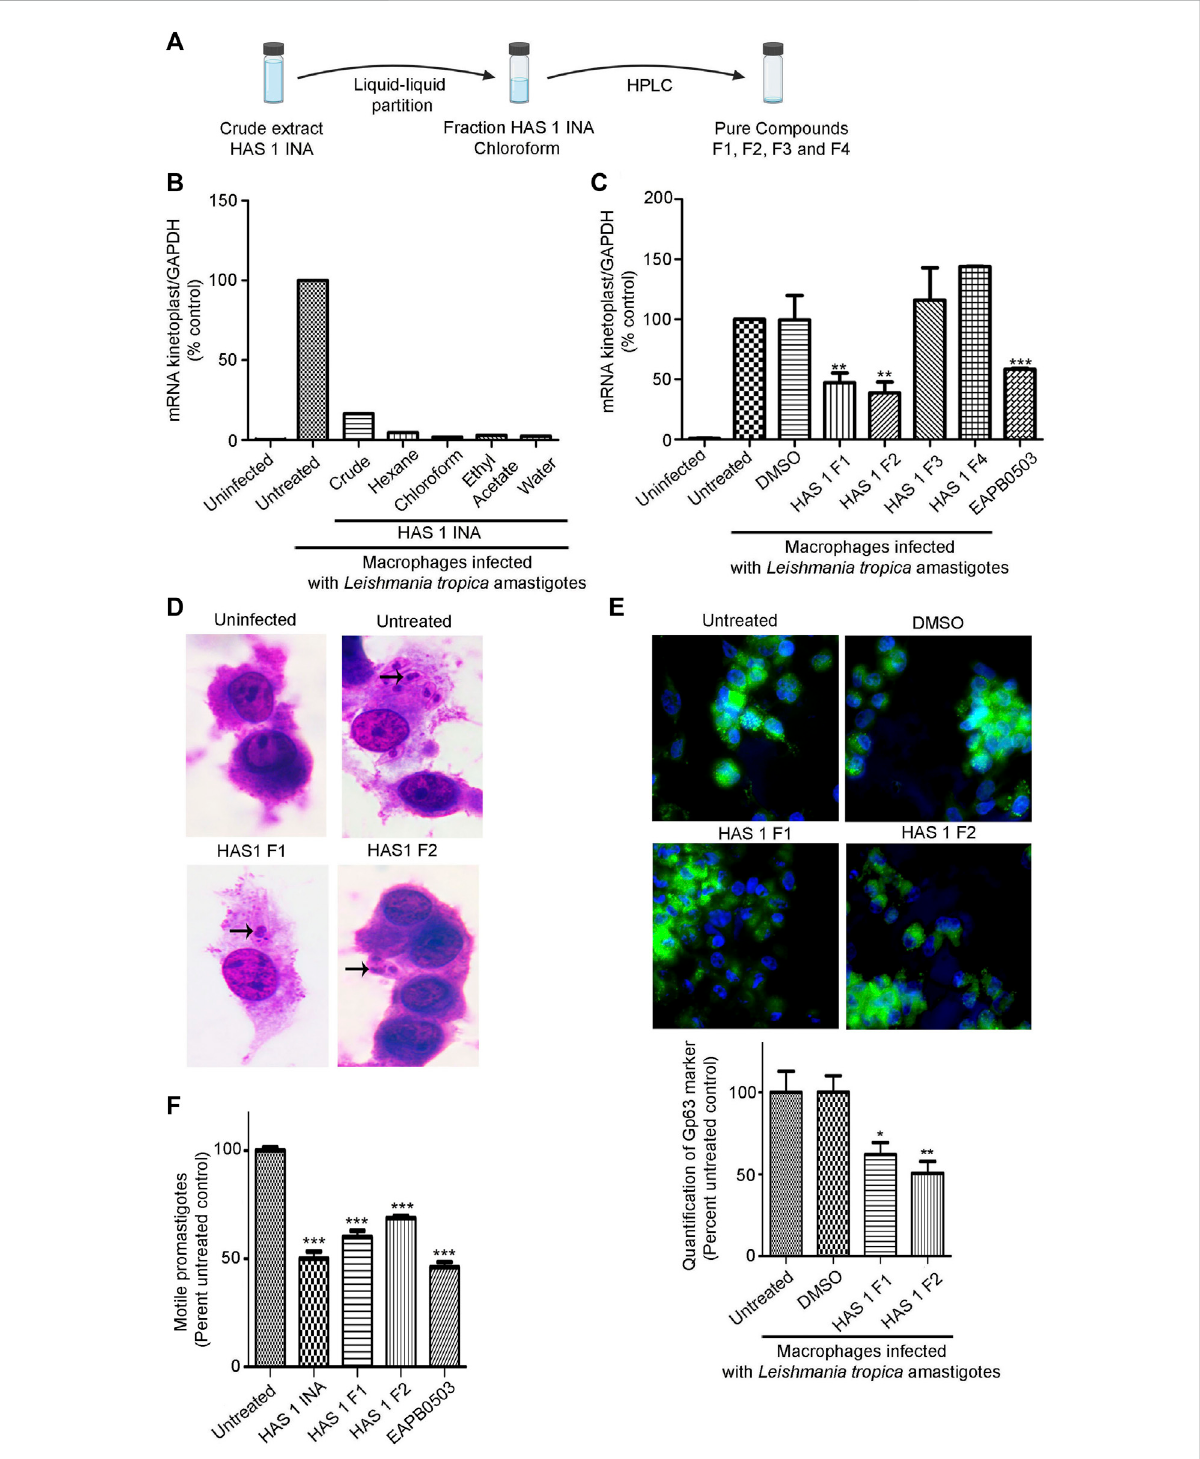
FIGURE 3 Bio-guided fractionation of the antileishmanial compounds of HAS1 INA. (A) . An upscaled fermentation of the HAS1 INA crude was fi rst subjected to liquid-liquid partition generating four fractions: HAS1 INA Hexane, HAS1 INA chloroform, HAS1 INA Ethyl Acetate, and HAS1 INA Water. HAS1 INA chloroform was further fractionated into four pure compounds using HPLC: HAS1-F1, HAS1-F2, HAS-F3, and HAS1-F4. (B,C). Real-time quantitative PCR detection of THP-1 derived macrophages infected with patient-derived L. tropica amastigotes treated with 0.01 μ g/ml of HAS1 INA fractions and the crude extract (B) or with 1 μ g/ml of the pure compounds for 24 h or with 1 μ M of EABP0503 for 24 h (C). Amastigote